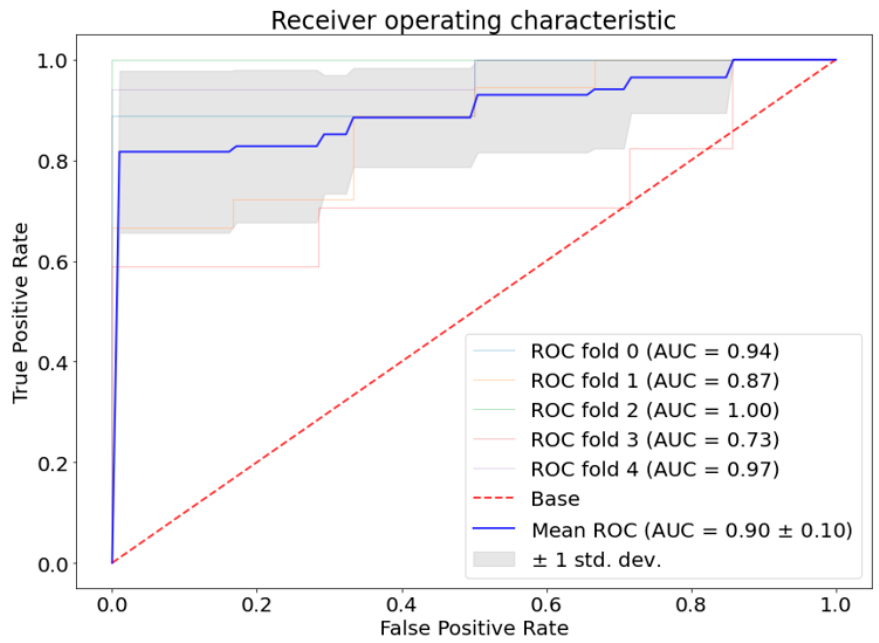
Figure 6. Performance analysis using a K-fold cross validation (K = 5). The mean AUC is 0.90 ± 0.10 in performance measurement.